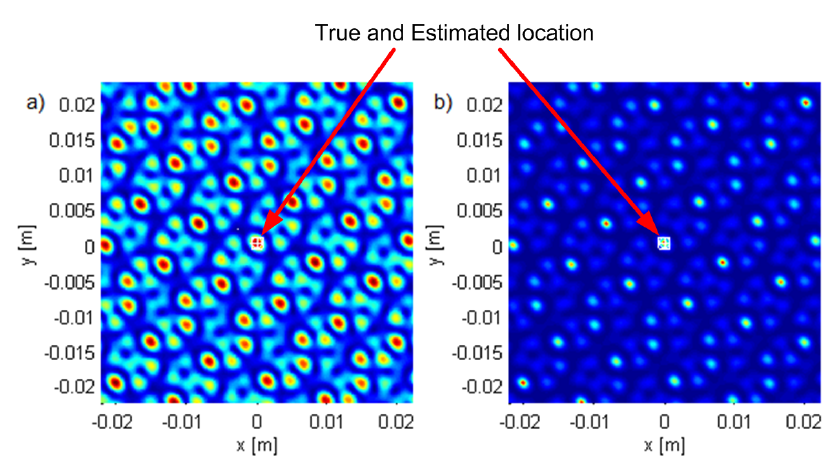
Figure 3. The criterion functions for G 5 and T 1 for ( a ) ML-US (magnitude in linear scale) and ( b ) SCM-MUSIC (magnitude in logarithmic scale).